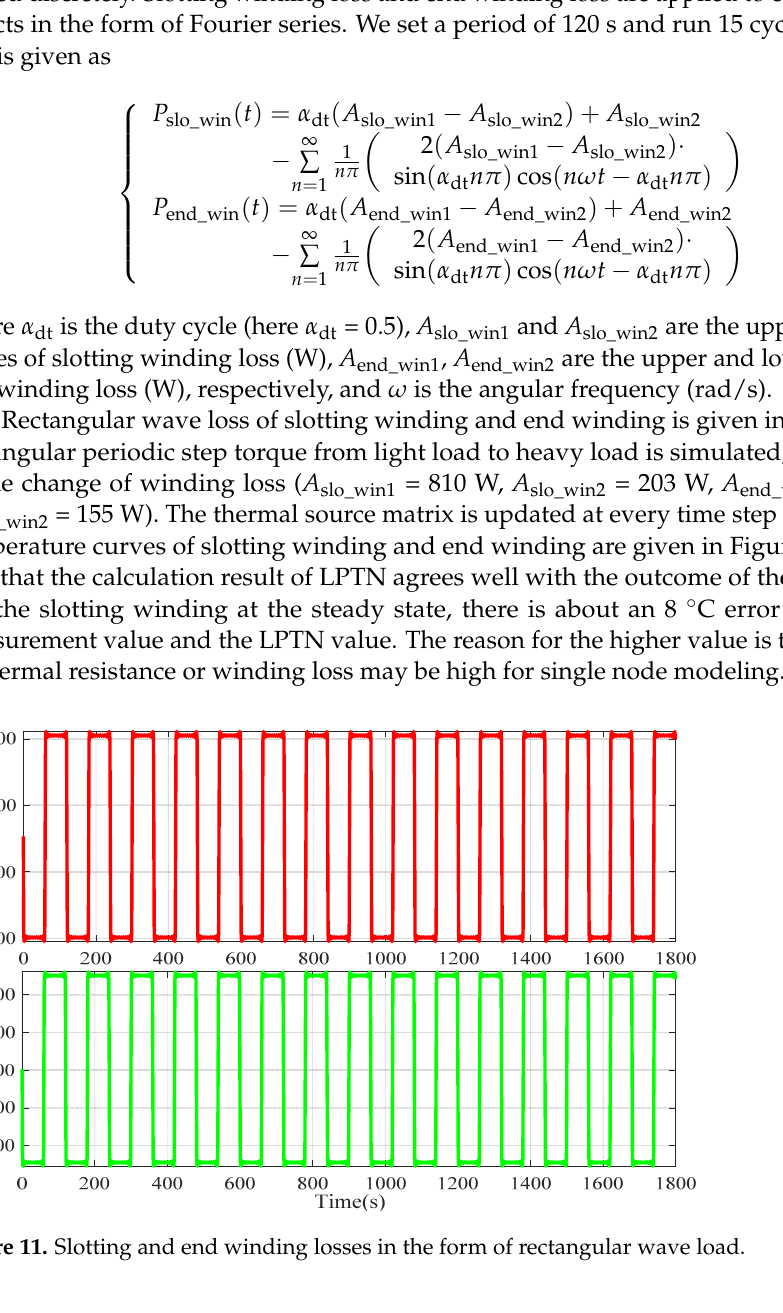
Figure 12. Transient temperature curve of end and slotting winding considering rectangular wave load. In order to verify the LPTN model, the prototype of 48-slot/8-pole IPMSM with “V” type rotor and ISDW stator is designed and manufactured. The stator and rotor are shown in Figure 13. A load test platform is established to validate its temperature rise and output characteristics, as shown in Figure 14.